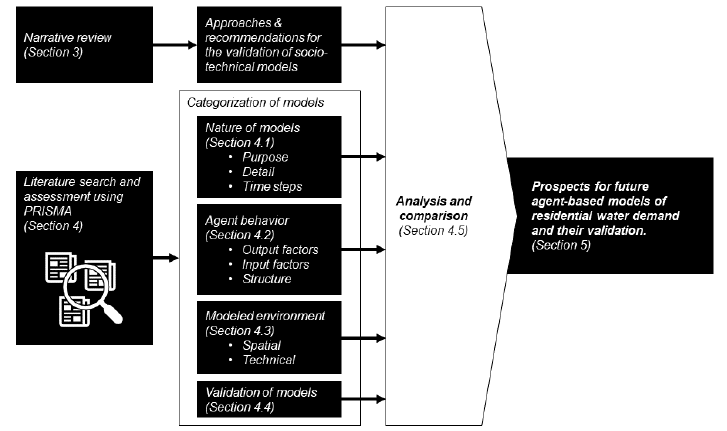
Figure 1. Summary of the review performed in this